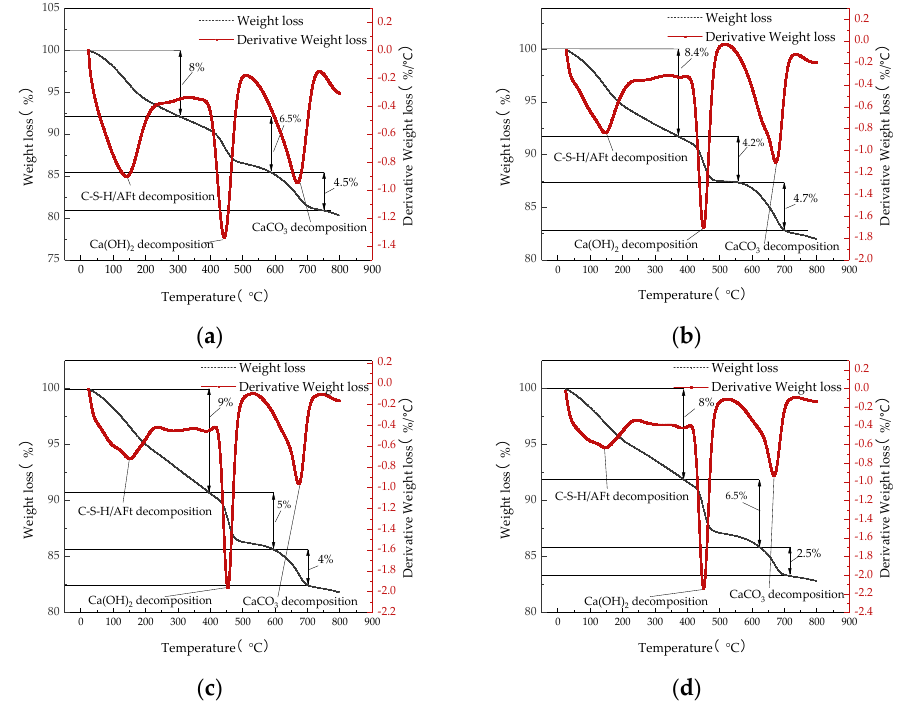
Figure 5. This TG ‐ DTA curve is with respect to ( a ) 7 d Na 2 SiO 3 /0g, ( b ) 7 d Na 2 SiO 3 /0.81g, ( c ) 28 d Na 2 SiO 3 /0 g, and ( d ) 28 d Na 2 SiO 3 /0.81 g.